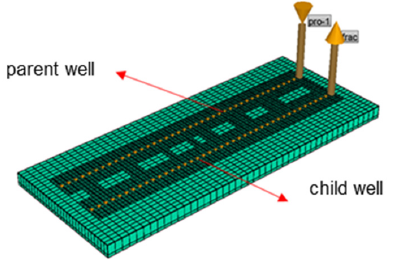
Figure 4. D grid mesh division of numerical model of parent well and child well. Table 1. Basic information of numerical model of W Block.